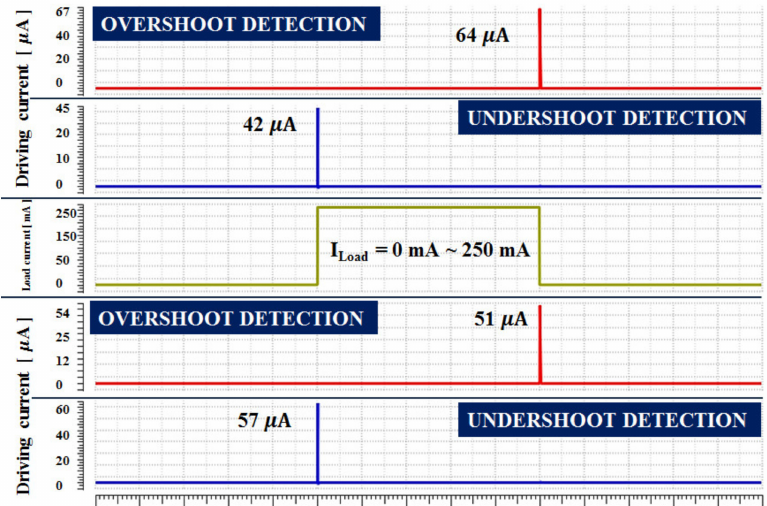
Figure 8. Simulation on the performance of the current supply and discharge path operated in the current driving buffer structure according to variation of load